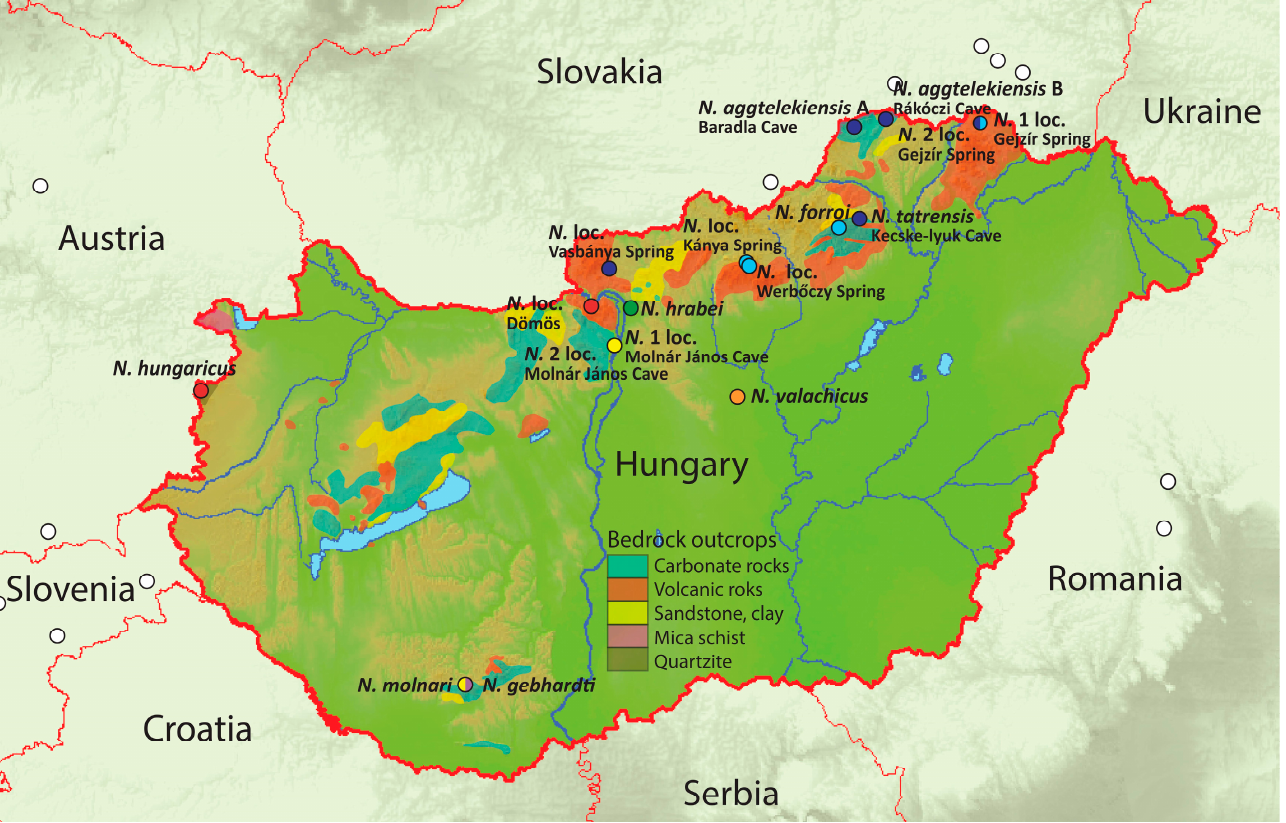
Figure 1. Sampling locations in Hungary (coloured circles) and the samples from surrounding regions (white circles). Colour codes for the Hungarian samples are the same as in Figures 2 and 3, representing clades revealed by this